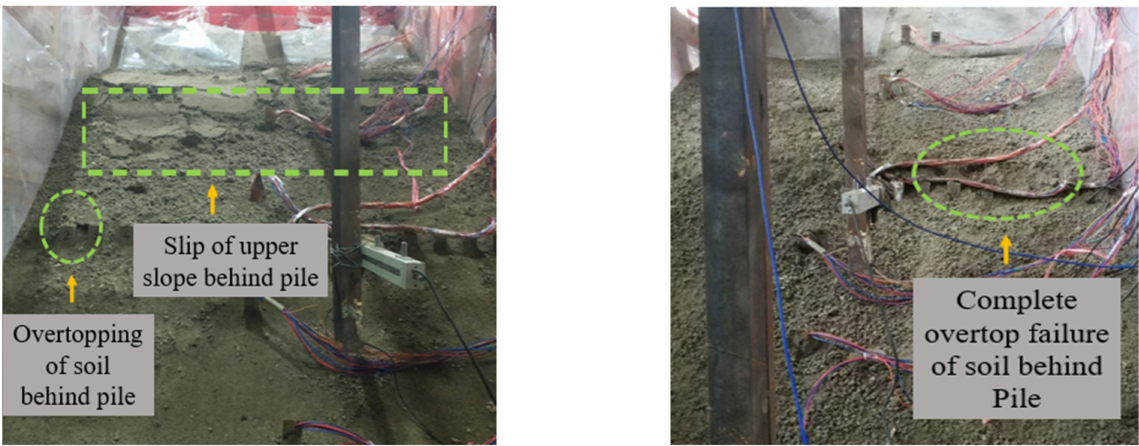
Figure 11. The 2nd ( left ) and 4th ( right ) loads of 0.6 g sine